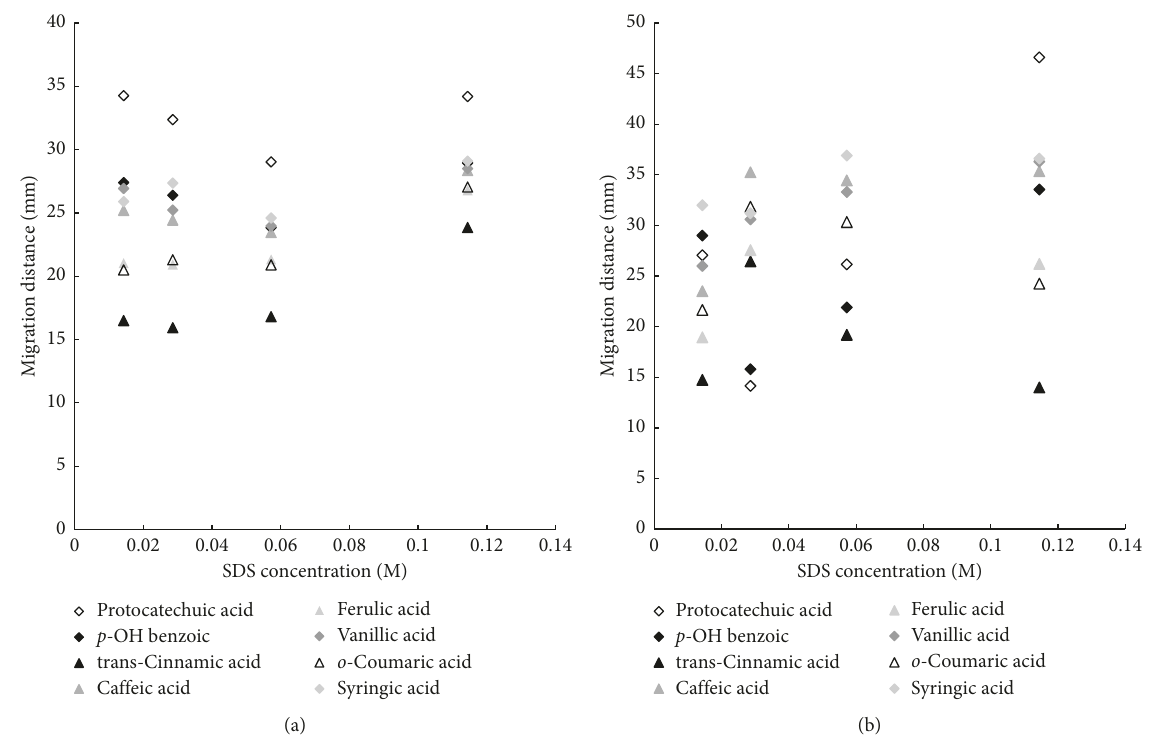
Figure 2: Migration distance of phenolic acids vs. SDS concentration in the mobile phase for HPTLC (a) and PPEC (b) experiments. The mobile phase: butanol (0.89 M; 8.14% v/v), 10% acetonitrile, and SDS in the range of 0.0143 to 0.1144M aqueous buffer of pH 7.0 (0.88 mM of citric acid and 8.23mM of disodium hydrogen phosphate). The stationary phase: HPTLC RP-18W. TLC: average experiment time 20min. PPEC: polarization voltage 800V; experiment time